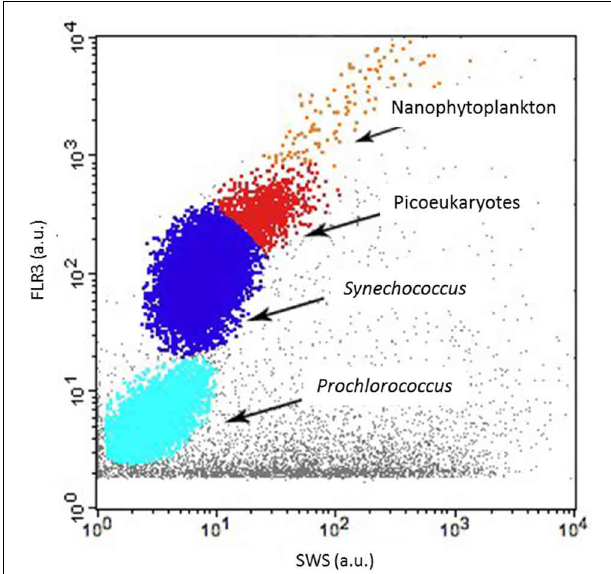
FIGURE 4 | Cytogram from the FACSCalibur flow cytometer with red fluorescence [FLR3 (a.u.)] vs. sideward scatter (SSC-H) showing the Prochlorococcus (not discussed in this paper), Synechococcus , picoeukaryotes and nanophytoplankton clusters.